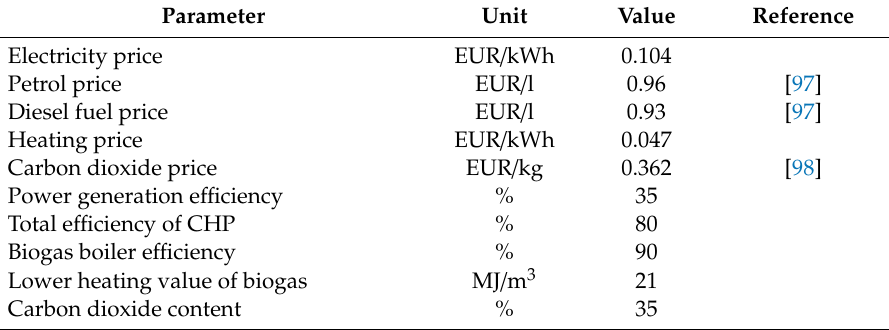
Table 3. Initial data. CHP, combined heat and power